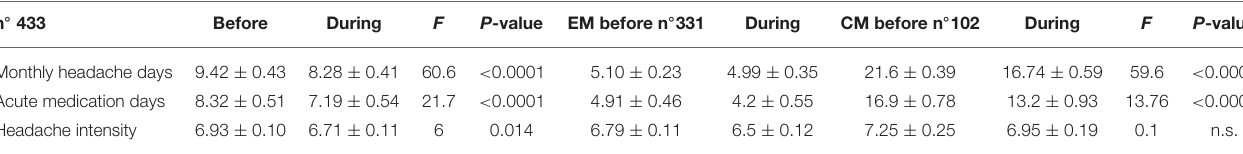
TABLE 2 | Comparison of headache features before and during lockdown period. n ◦ 433 Before During F P -value EM before n ◦ 331 During CM before n ◦ 102 During F P -value